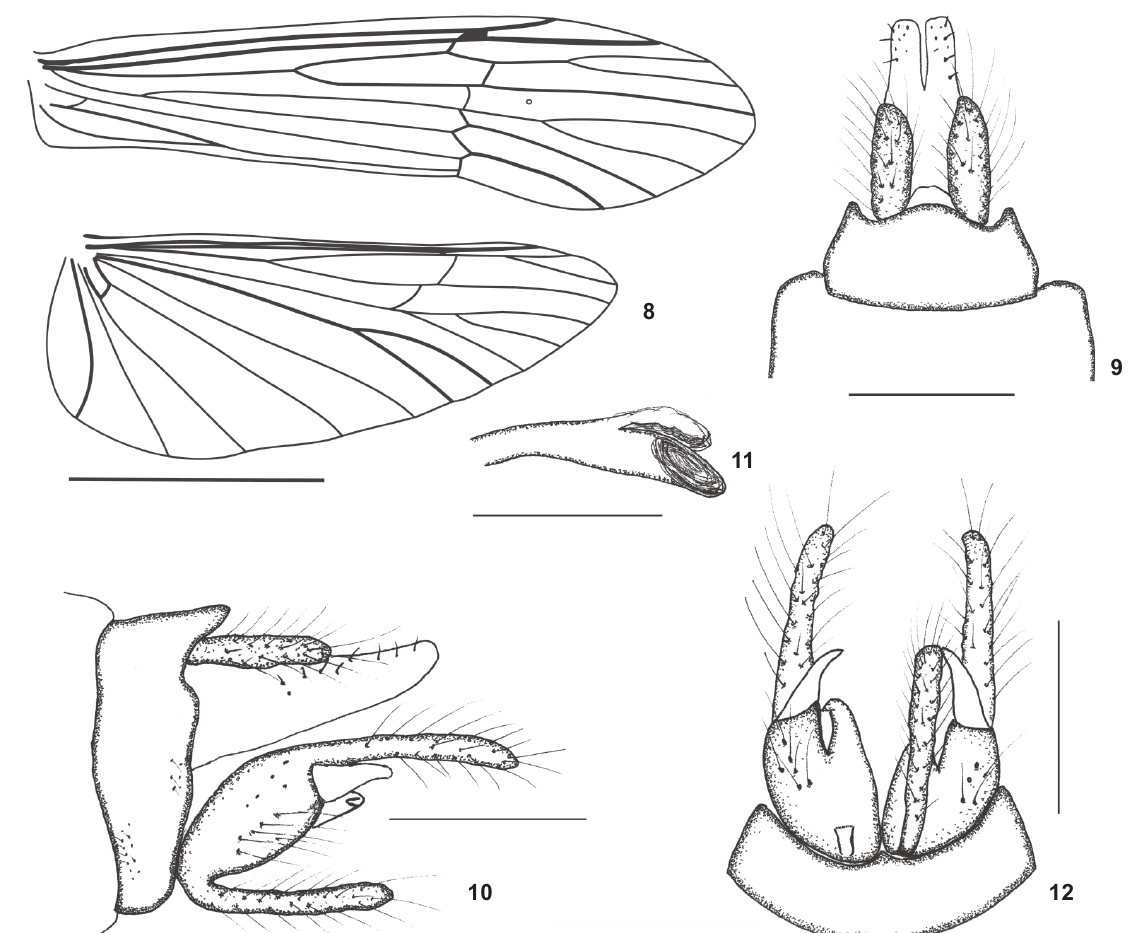
Figures 8-12. Triplectides qosqo sp. nov. , male: (8) Fore and hind wings; (9) genitalia, dorsal view; (10) genitalia, lateral view; (11) phallic apparatus, lateral view; (12) genitalia, ventral view.